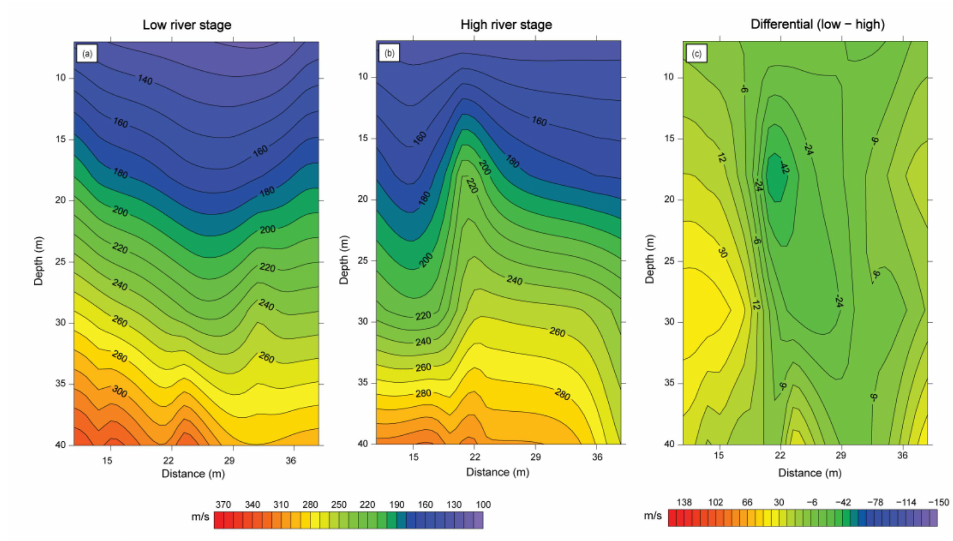
Figure 7. East side (355 m from levee toe) shear-wave seismic profiles. Kriging-interpolated CMP- based interval velocities during ( a ) low and ( b ) high river stages, and ( c ) the differential shear-wave velocity. Mean = 2 m/s and standard deviation = ± 24